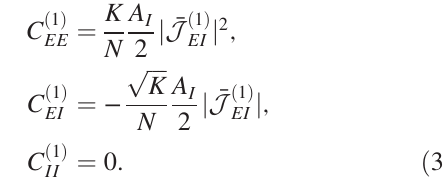
1 Þ 1 Þ 1 Þ ¼ f ð ¼ f ð ¼ EE EI IE